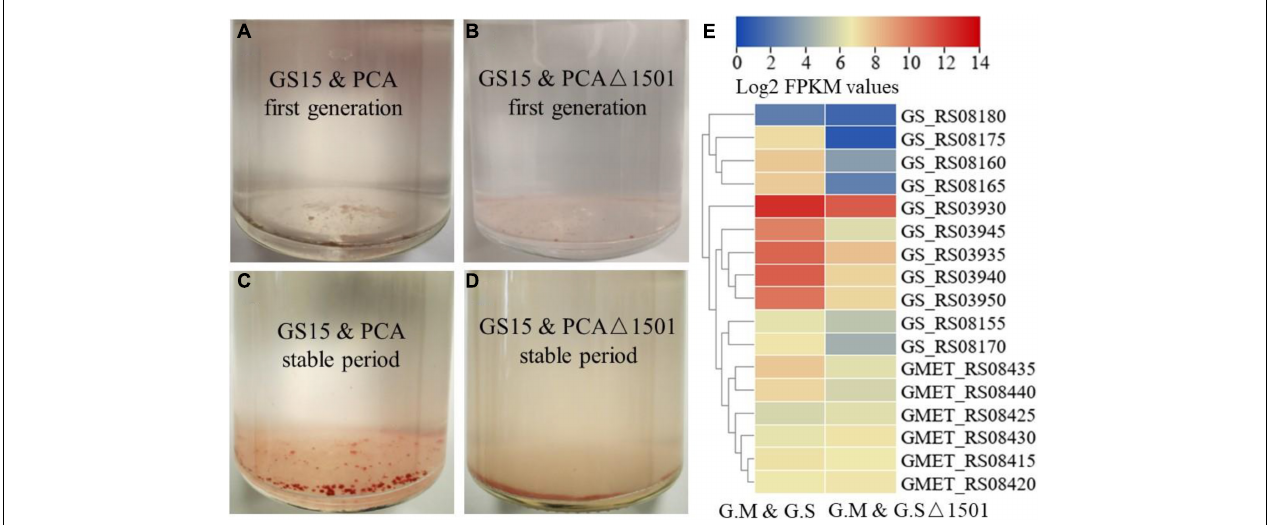
FIGURE 3 | Morphology of the GS15 and PCA co-culture (A) and the GS15 and PCA (cid:49) 1501 co-culture (B) in the first generation. Morphology of the GS15 and PCA co-culture (C) and the GS15 and PCA (cid:49) 1501 co-culture (D) in the metabolic stable period. Heat map comparison of related genes of hybrid subunits and flavin of G. metallireducens and G. sulfurreducens in the GS15 and PCA co-culture and the GS15 and PCA (cid:49) 1501 co-culture (E) .